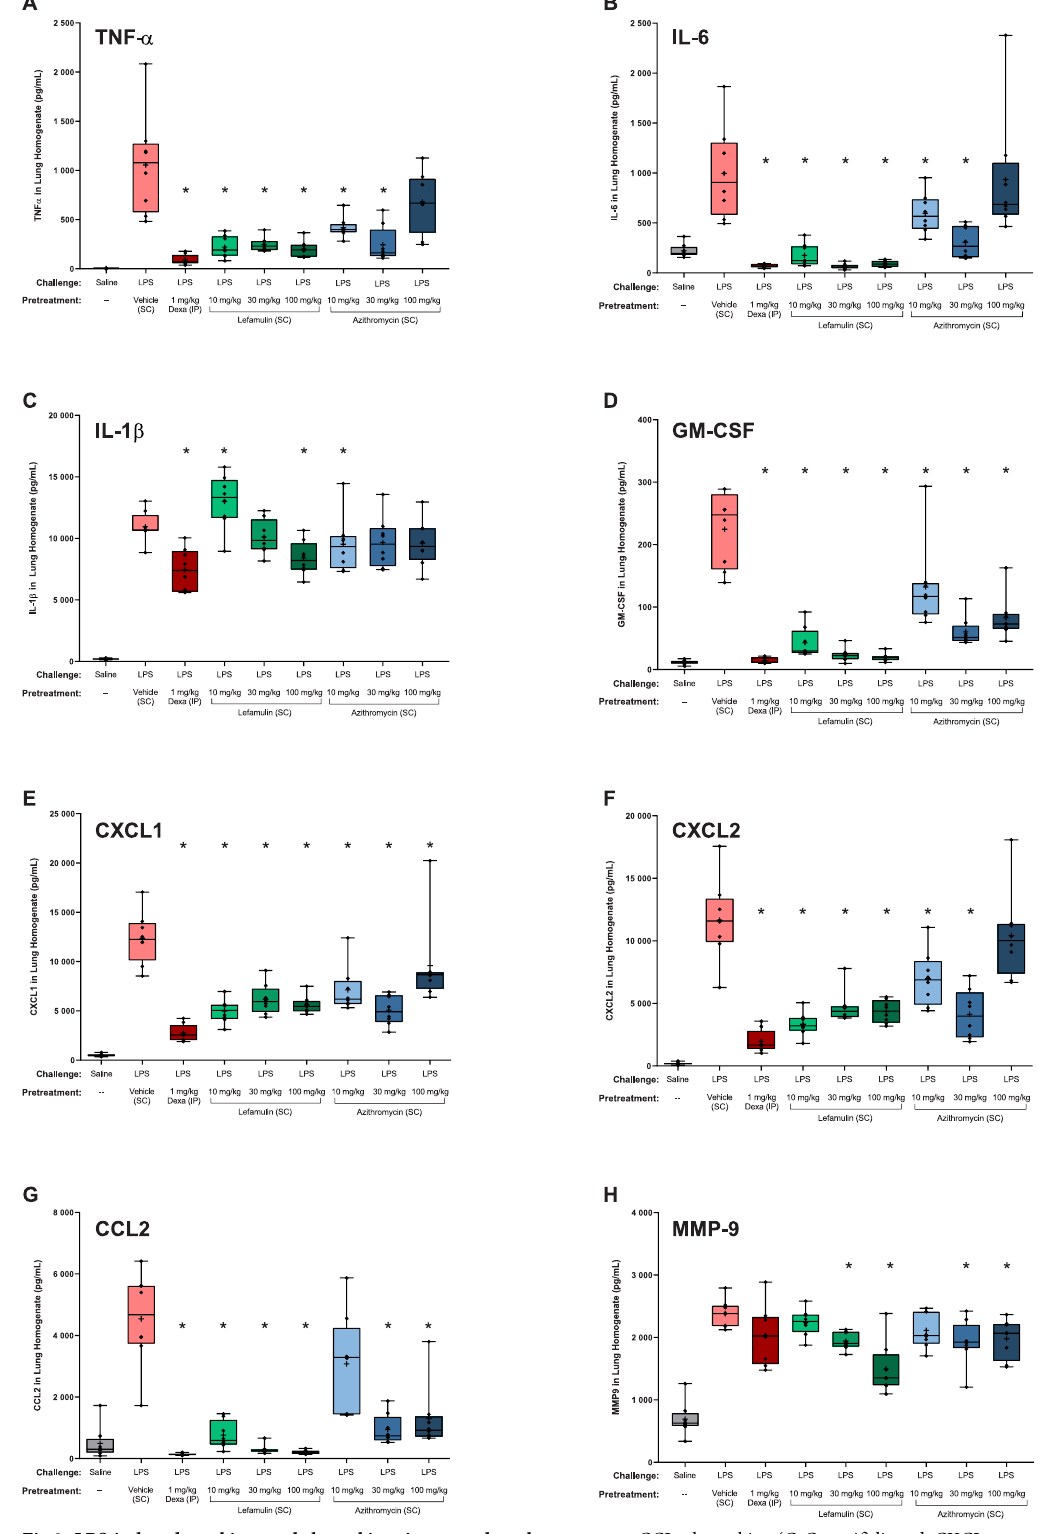
Fig 2. LPS-induced cytokines and chemokines in mouse lung homogenate. CCL, chemokine (C-C motif) ligand; CXCL, chemokine (C-X-C motif) ligand; Dexa, dexamethasone; GM-CSF, granulocyte-macrophage colony-stimulating factor;